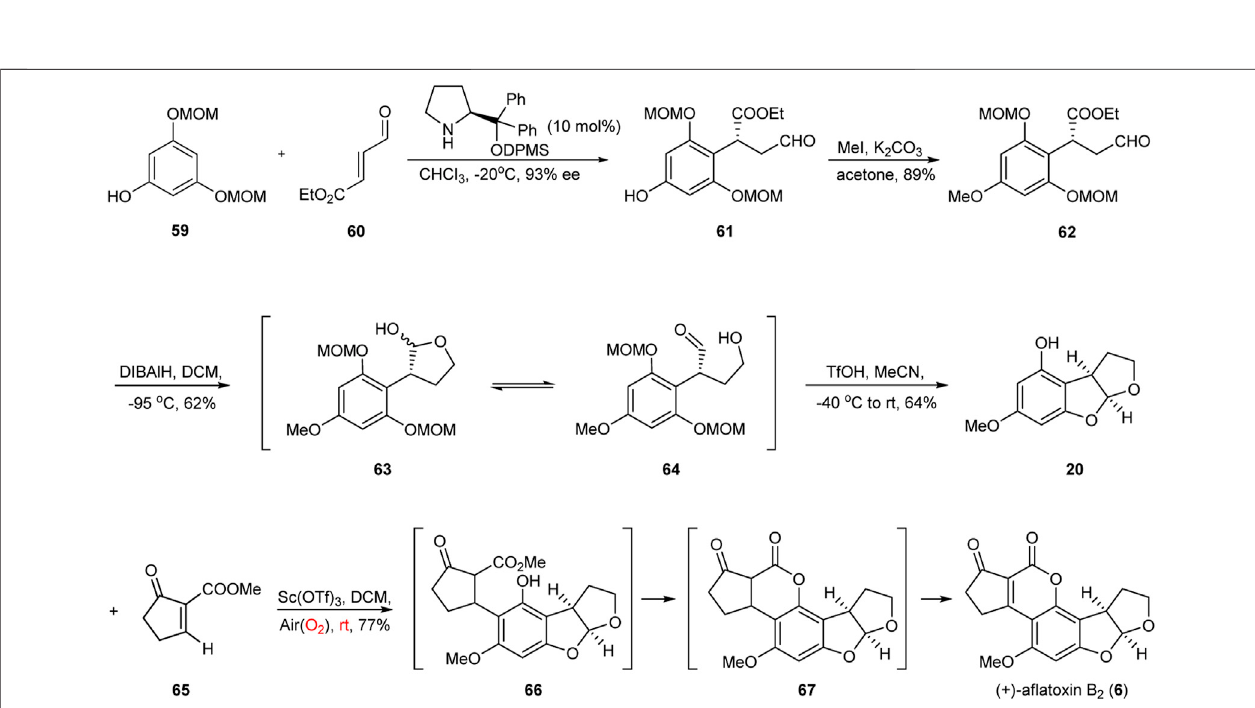
FIGURE 8 | Asymmetric total synthesis of a fl atoxin B